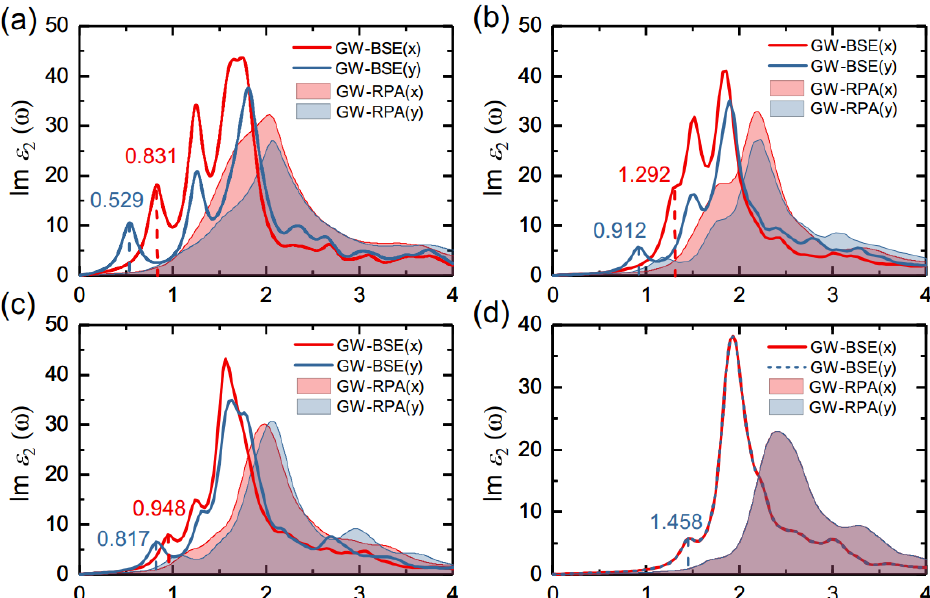
Figure 3. Imaginary part of the dielectric functions of monolayers ( a ) SiTe, ( b ) GeTe, ( c ) SnTe, and ( d ) PbTe with (GW–BSE) and without (GW–RPA) e–h interactions for linearly polarized light along the x and y directions.